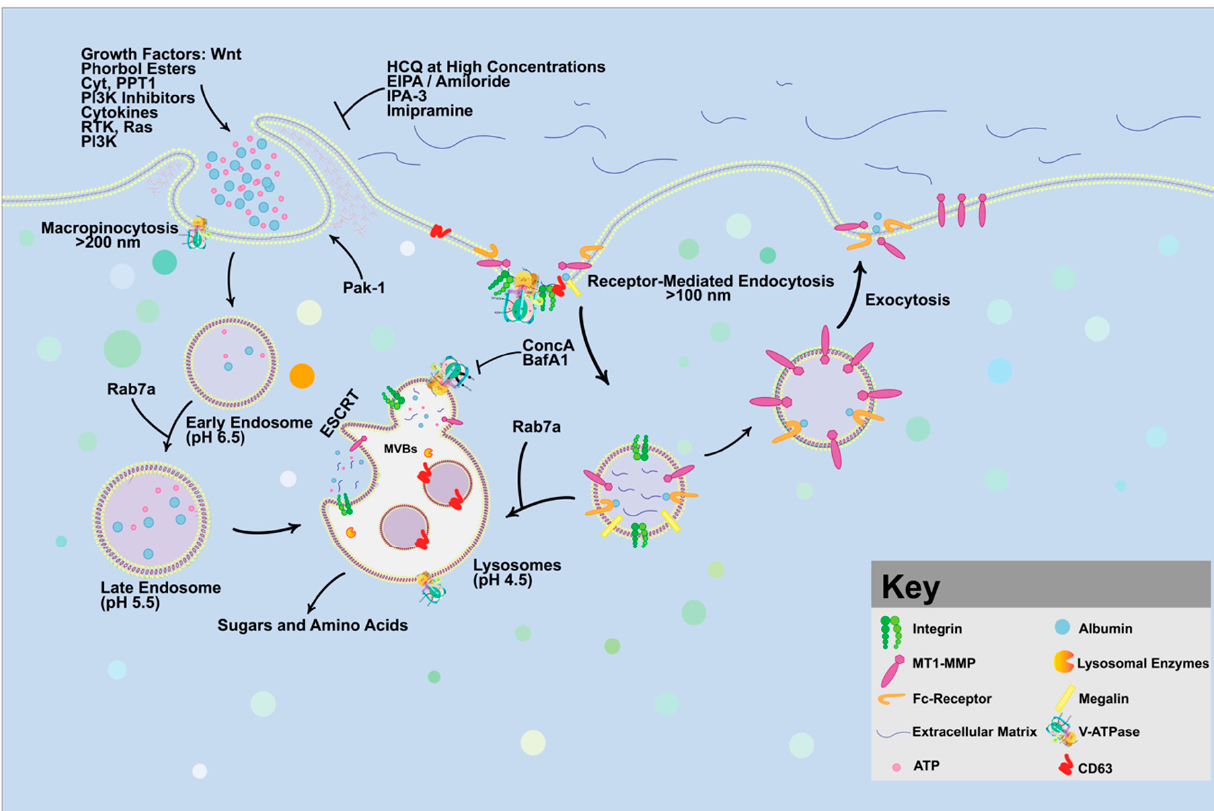
Figure 4. Targeting macropinocytosis as a promising therapeutic strategy for cancer. Macropinocytosis is prominent in several types of cancer, such as colon, pancreatic, lung, prostate, and bladder. Through macropinocytosis, serum proteins and a host of extracellular glycoproteins enter the cellular fluid compartment to either be recycled out of the cell or directed to lysosomes for degradation in order to generate key metabolites that fuel cell growth and proliferation. Vacuolar ATPase (V- ATPase) is an essential regulator of RAS-induced micropinocytosis as well as the serine/threonine p21-activating kinases, known as PAK-1 protein. Several inhibitors can block membrane trafficking, macropinocytosis, and lysosomal activity, which affect tumor growth and reveal its important role in cancer. Therefore, macropinocytosis represents a metabolic vulnerability that can be leveraged to therapeutically target macropinocytic tumors by limiting their access to nutrients.